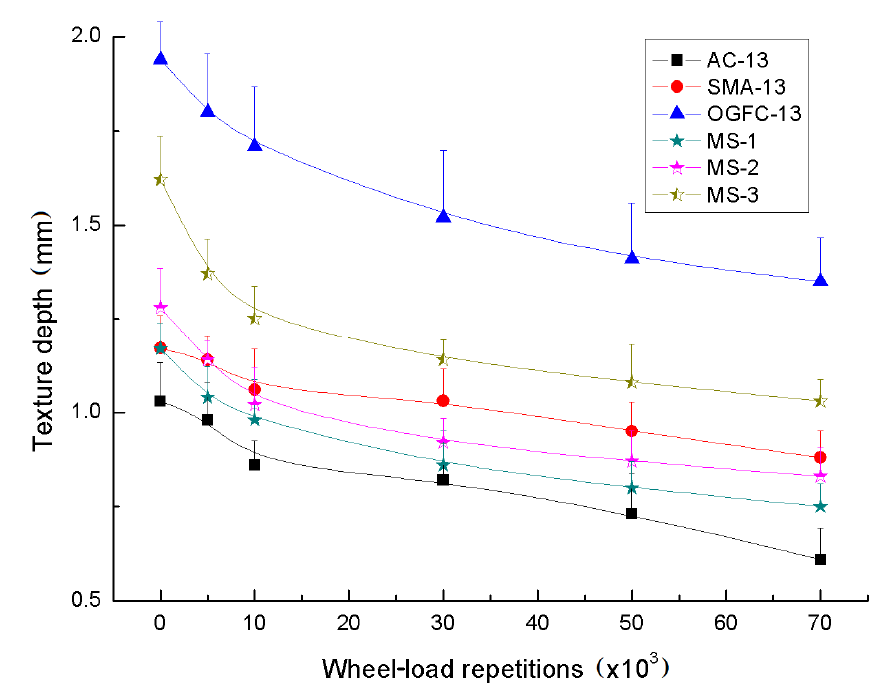
Figure 10. Texture depth of the mixture under different wheel-load repetitions.